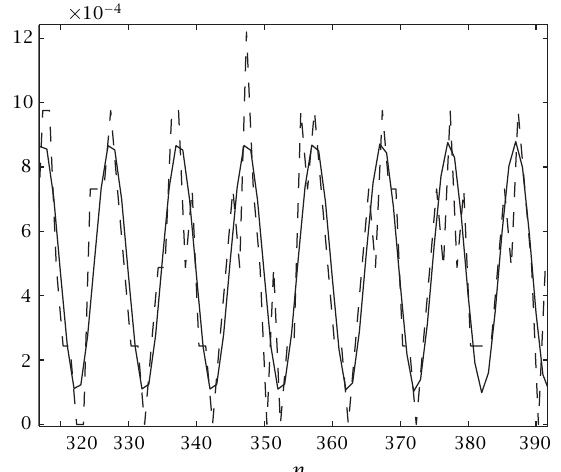
Figure 3: Comparison between the initial density f(t) (continuous line) and the estimated version ˆ f(t) (dashed line) obtained with the kernel method. Notice how poor seems the quality of the estimated density ˆ f(t) . Despite this apparently bad estimation, the estimated instantaneous power spectrum will show clearly the presence of a time-varying frequency in the data.